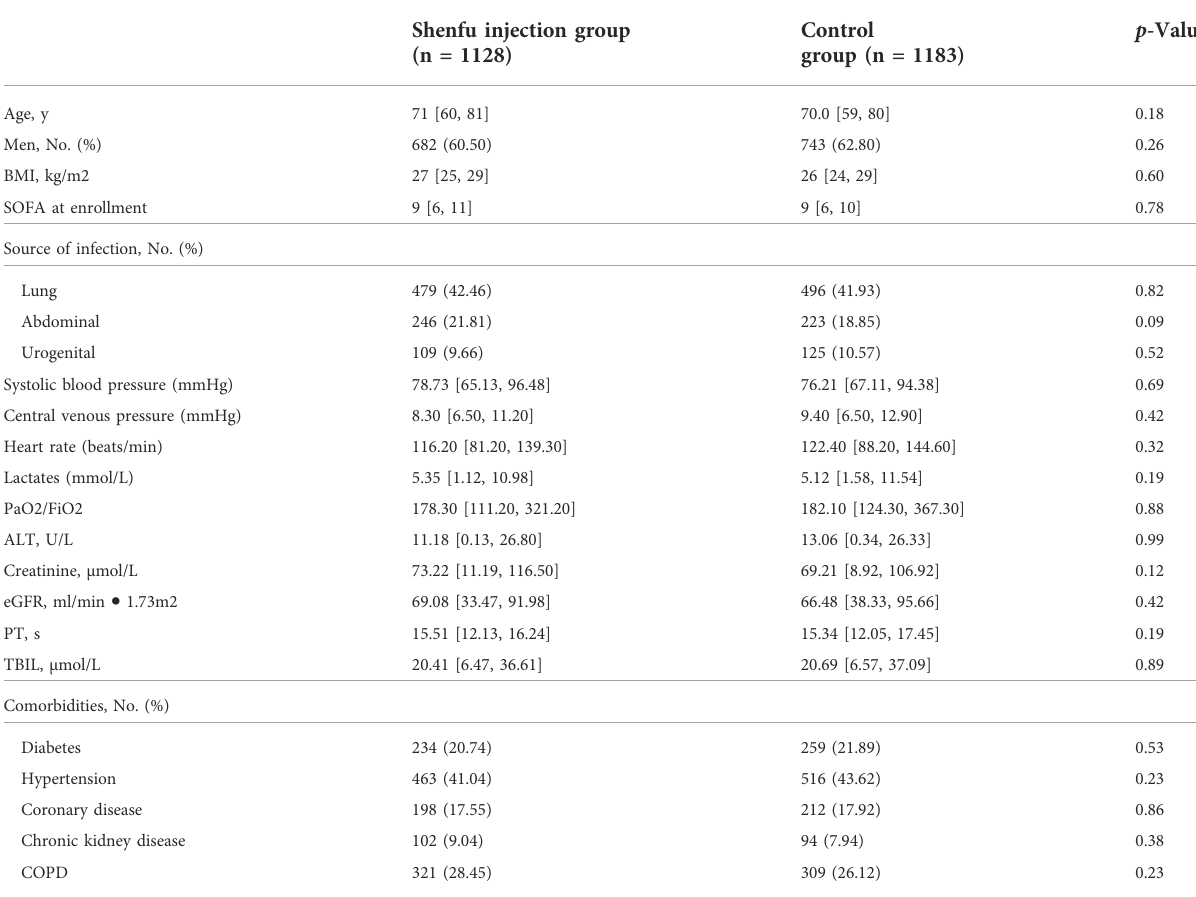
TABLE 1 Baseline demographics of